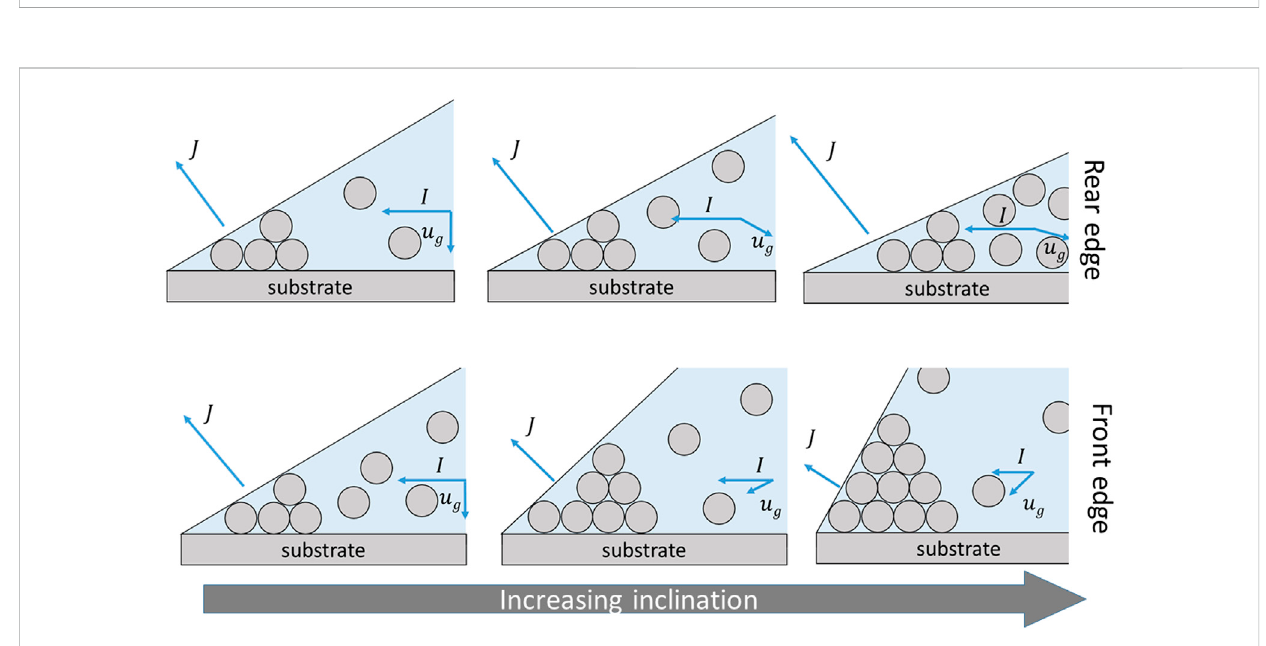
Schematic illustrating how inclination affects the mechanism of particle deposition at the rear and front sides of a drop, top and bottom row respectively, for increasing inclination from left to right. In all cases, the deposit becomes large enough to stagnate the fl ows carrying